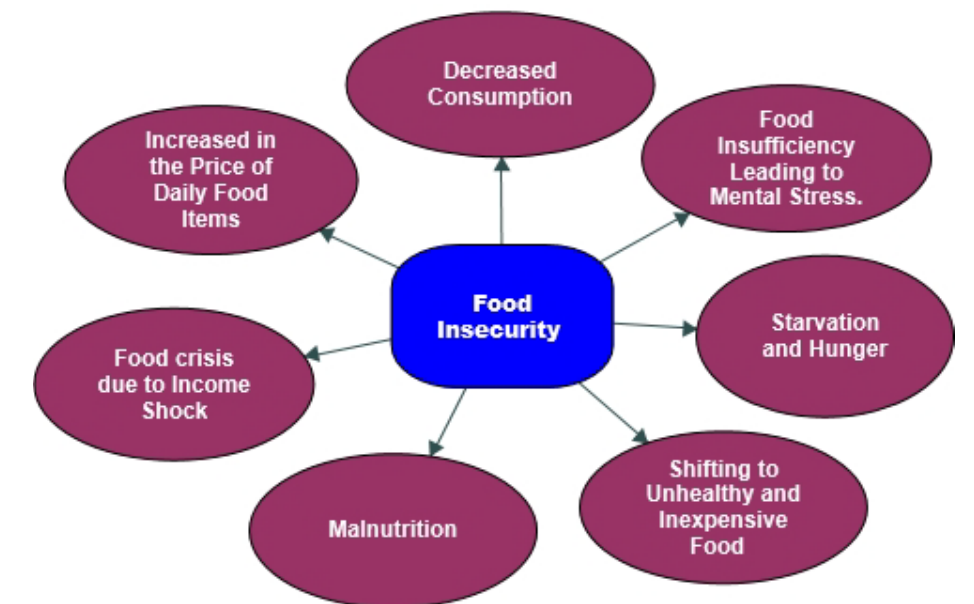
Figure 3. Thematic issues of food insecurity during COVID-19. Table 4. Defined themes that were derived from the thematic